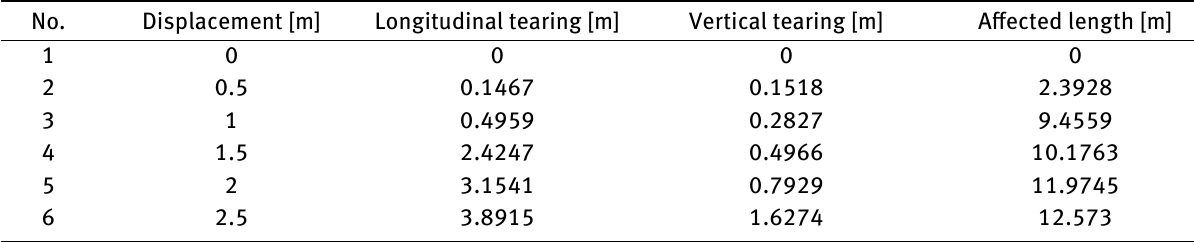
Table A.2: Summary of the damage assessment on the SSS: impact to the outer shell No.